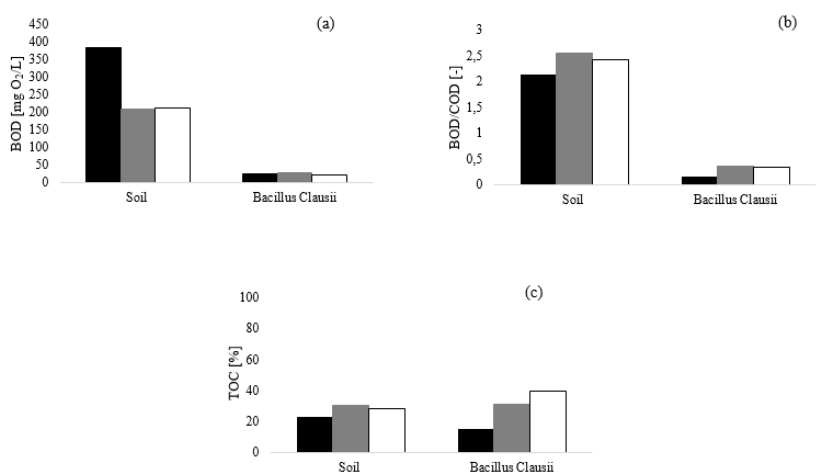
Figure 2. BOD ( a ), biodegradation index ( b ) and TOC removal ( c ) after five days in closed bottle tests. Conditions: 2.0 mL of Bacillus Clausii or inoculum from soil humus (soil) and 0.10% as concentration of the conditioning mixtures A (black), B (gray) and C (white) in demineralized water solutions.